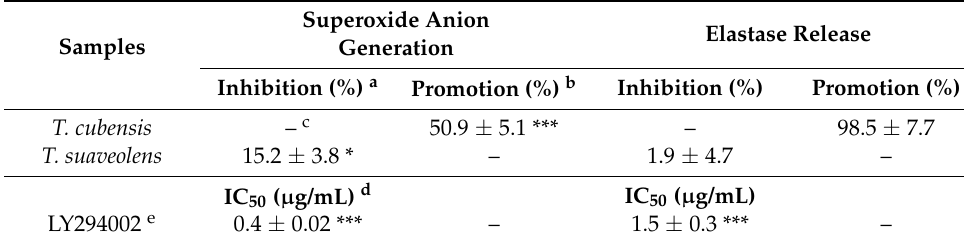
Table 1. Preliminary bioactivity screening of fruiting bodies of T. cubensis and T. suaveolens